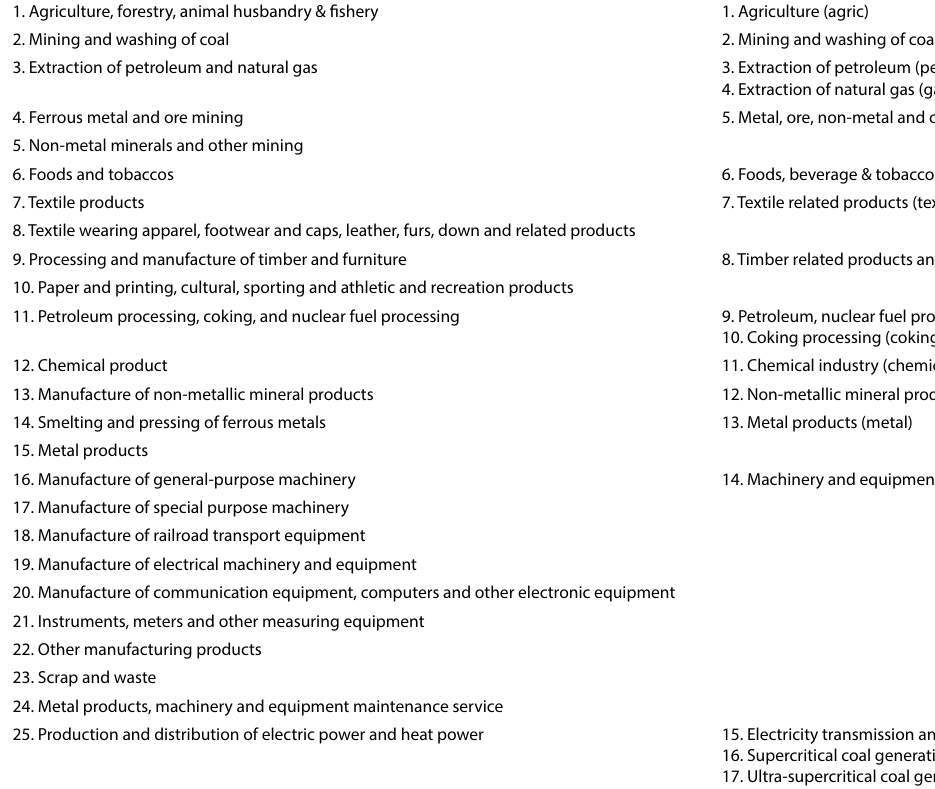
Table 3 The sector division of the Chinese